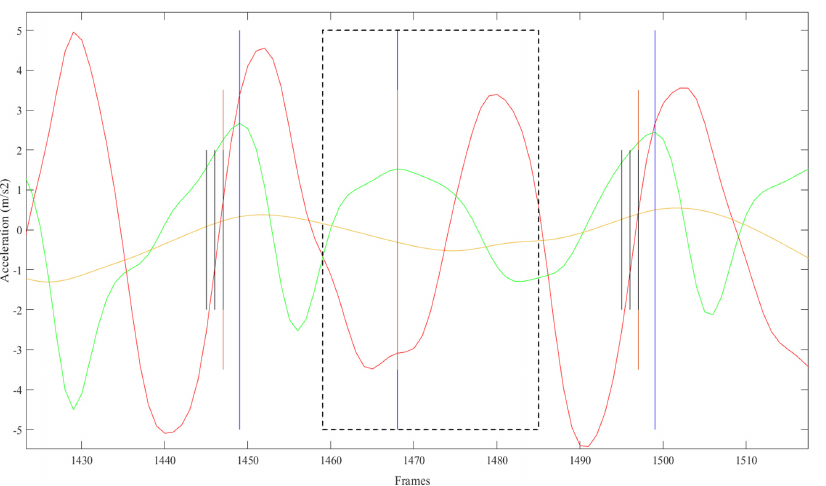
Figure 3. Missed step (vertical blue line) identified within adjusted search range (black dotted line). FS inserted (vertical orange line) at timestamp for the peak AP acceleration (green line) in this period.